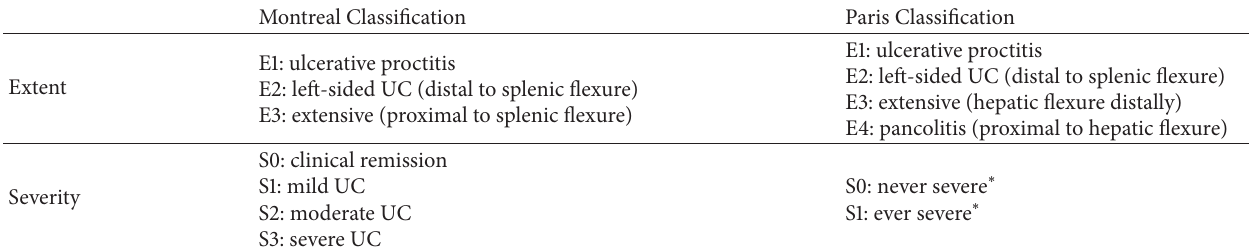
Table 3: Comparison of Montreal and Paris Classifications for ulcerative colitis based on Levine et al. [13].